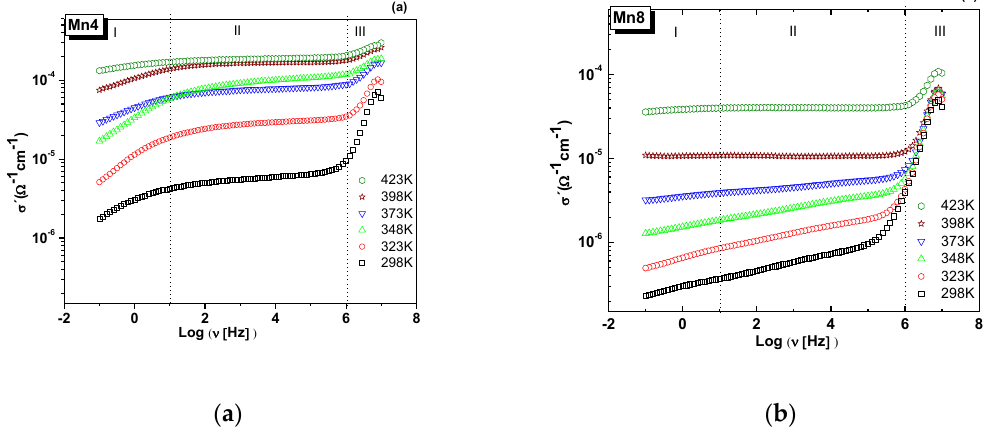
Figure 6. E ff ect of temperature on bulk relaxation time ( τ b ) for the synthesized birnessite-type material.